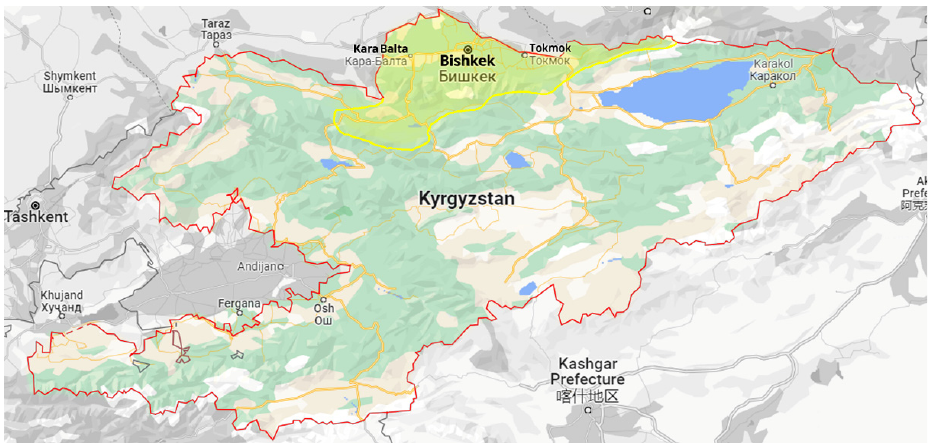
Figure 1. Area of northern Kyrgyzstan surveyed in 2020, marked with yellow